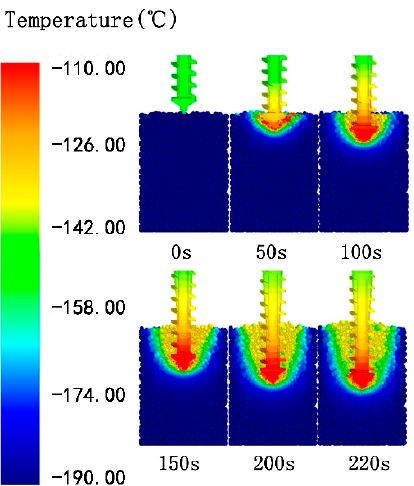
Figure 13. Temperature distribution of drill tool and simulated lunar soil particles in No. A2 at various intervals.